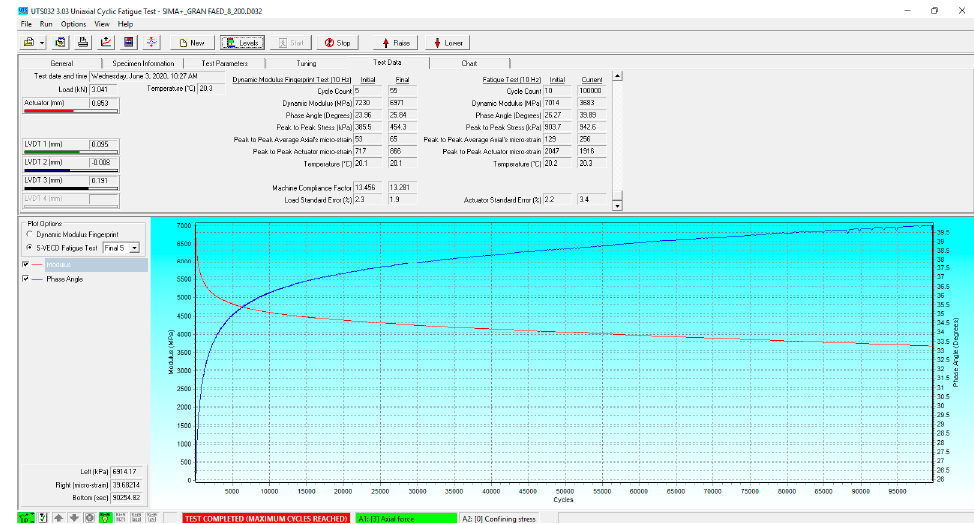
Figure 4. Screenshot of the outputs registered during the uniaxial fatigue test.